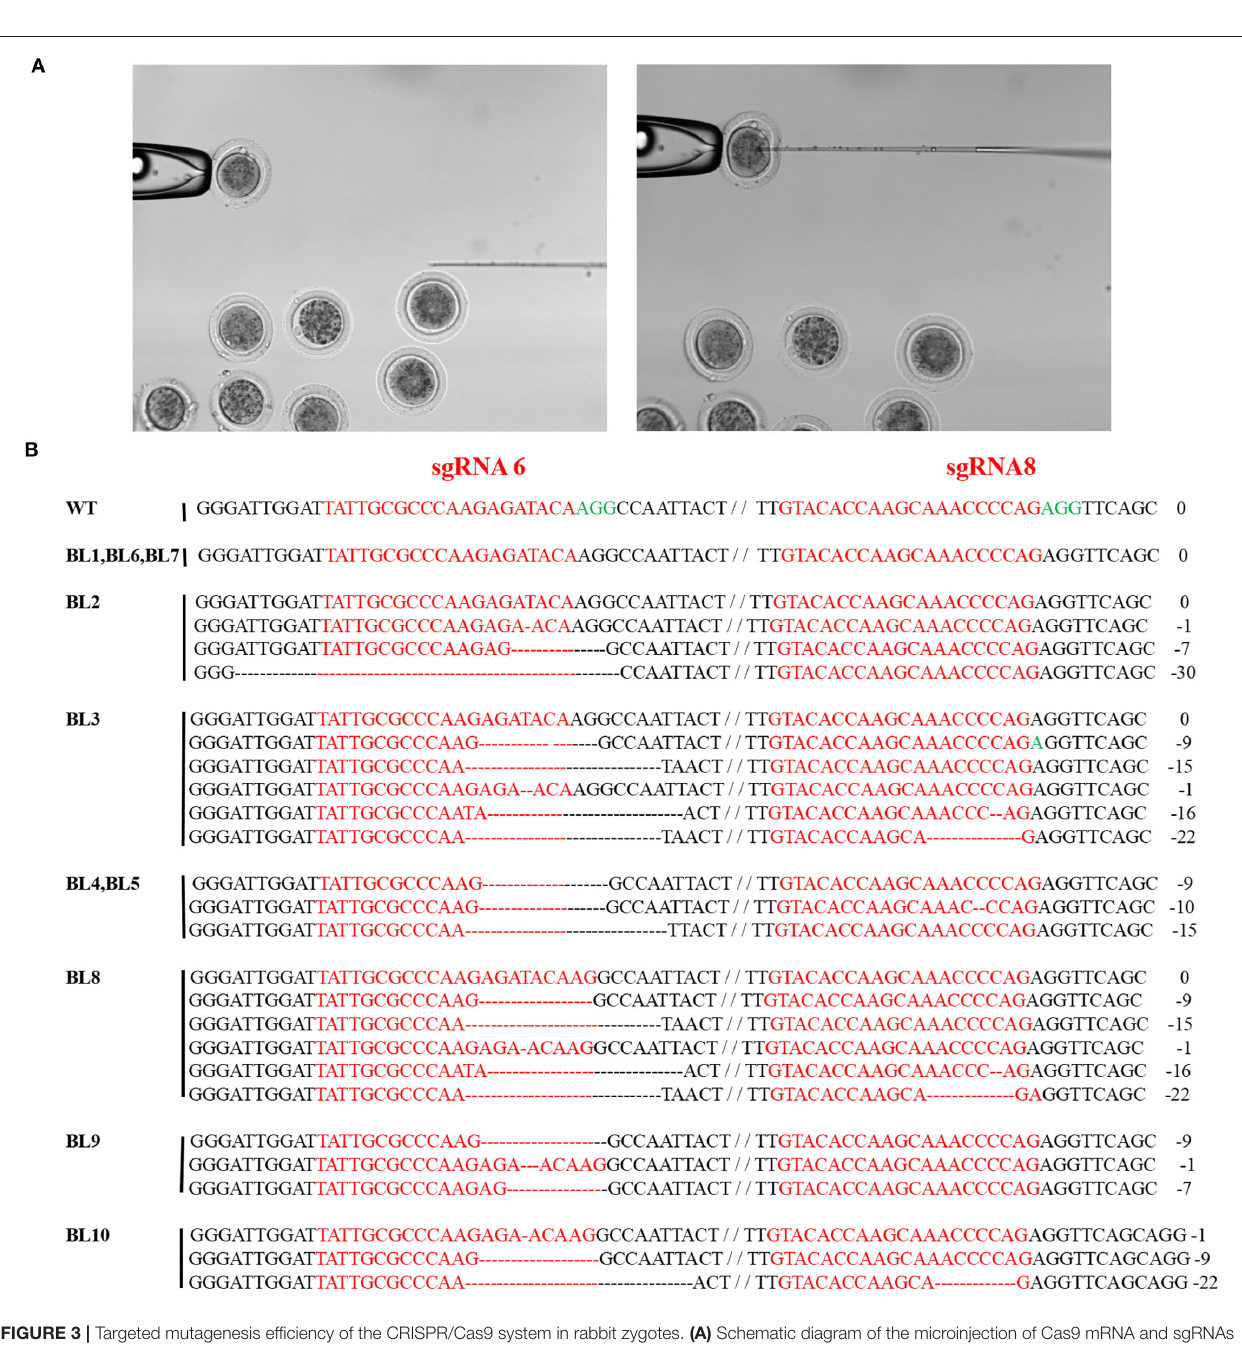
of insertion type rabbits was 3,398 ± 92.97 g, deletion type rabbits 3,554 ± 110.45 g, and WT rabbits 3,064 ± 80.35 g ( P